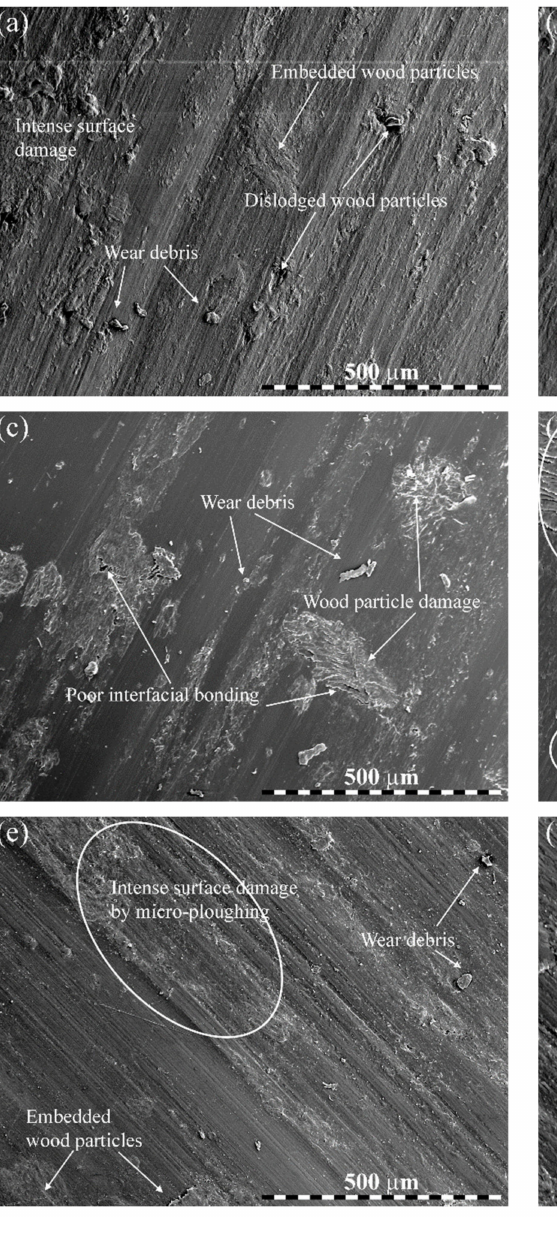
Figure 9. Worn micrographs of biocomposites: ( a , b ) 5 wt.%, ( c , d ) 7.5 wt.%, and ( e , f ) 10 wt.% wood waste-filled biocomposites at lower and higher